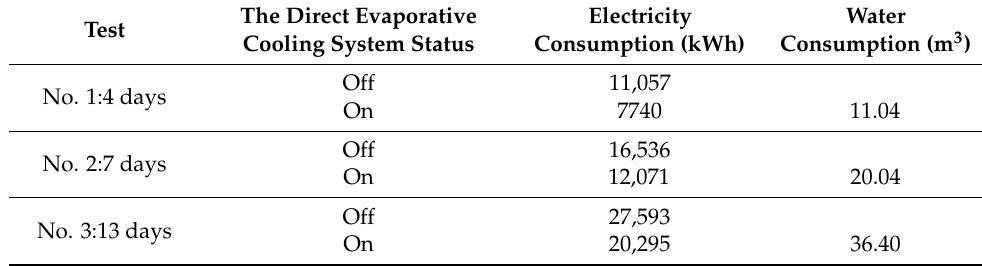
Table 1. Results of the Tests.